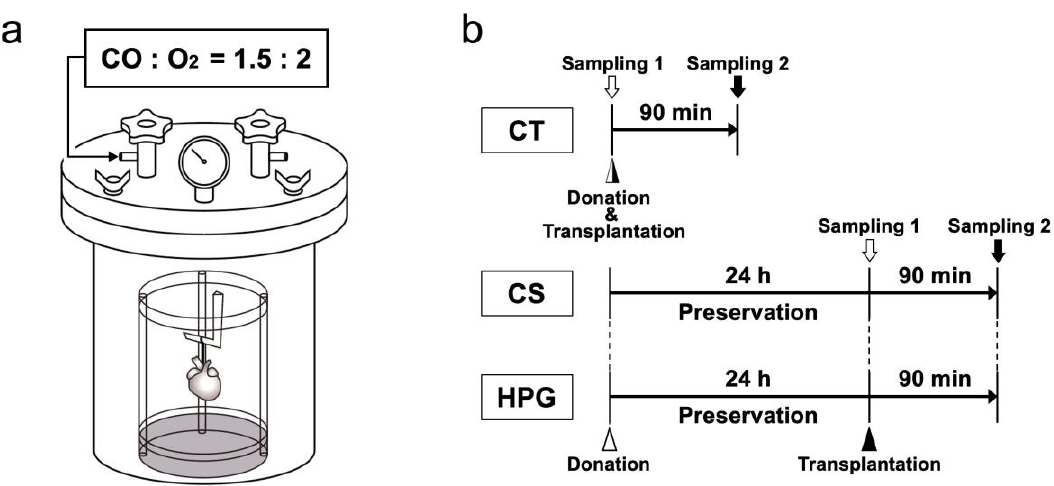
Figure 6. Schematic representation of the preservation method and experimental